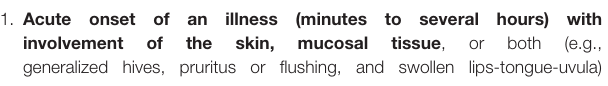
TABLE 1 | Summary of consensus statements (CS). TABLE 2 | Anaphylaxis according to National Institute of Allergy and Infectious Disease and the Food Allergy and Anaphylaxis Network (11) (NIAID/FAAN). Anaphylaxis is likely when one of the three criteria is fulfilled: